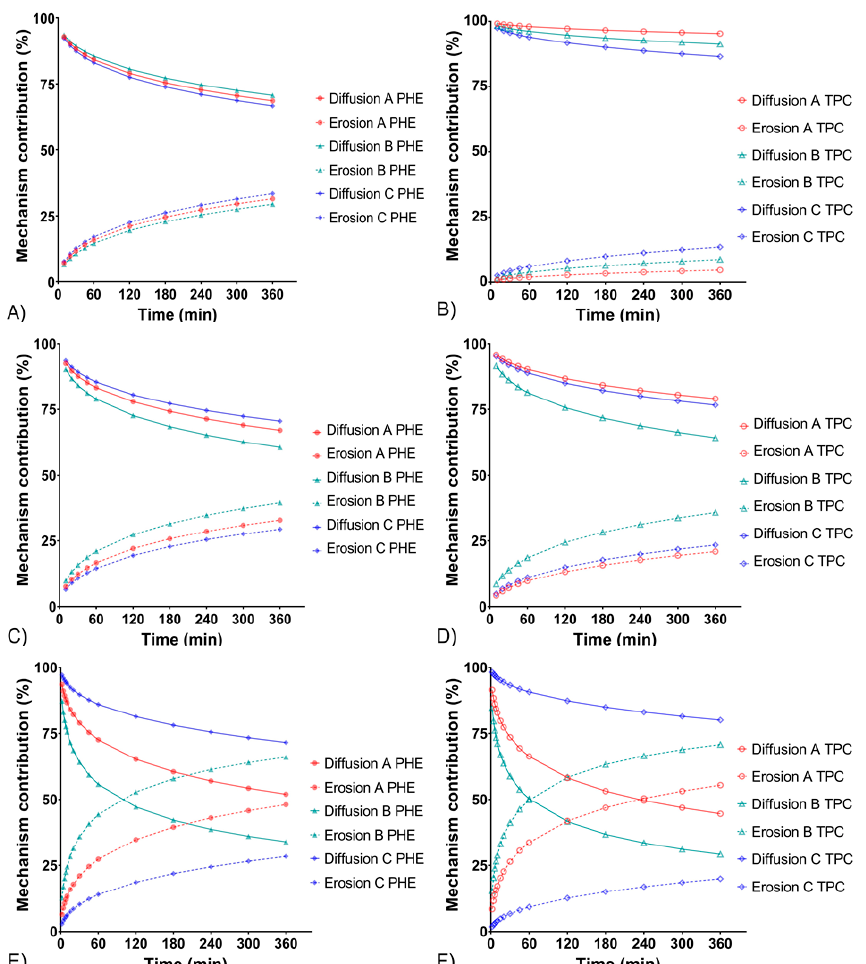
Figure 2. Percentages of diffusion and erosion contributions as a function of time of formulations A, B, and C. PHE mechanism contributions at 3 mL/min ( A ), 8 mL/min ( C ), and 15 mL/min ( E ) flow rates. TPC mechanism contributions at 3 mL/min ( B ), 8 mL/min ( D ) and 15 mL/min ( F ) flow rates.